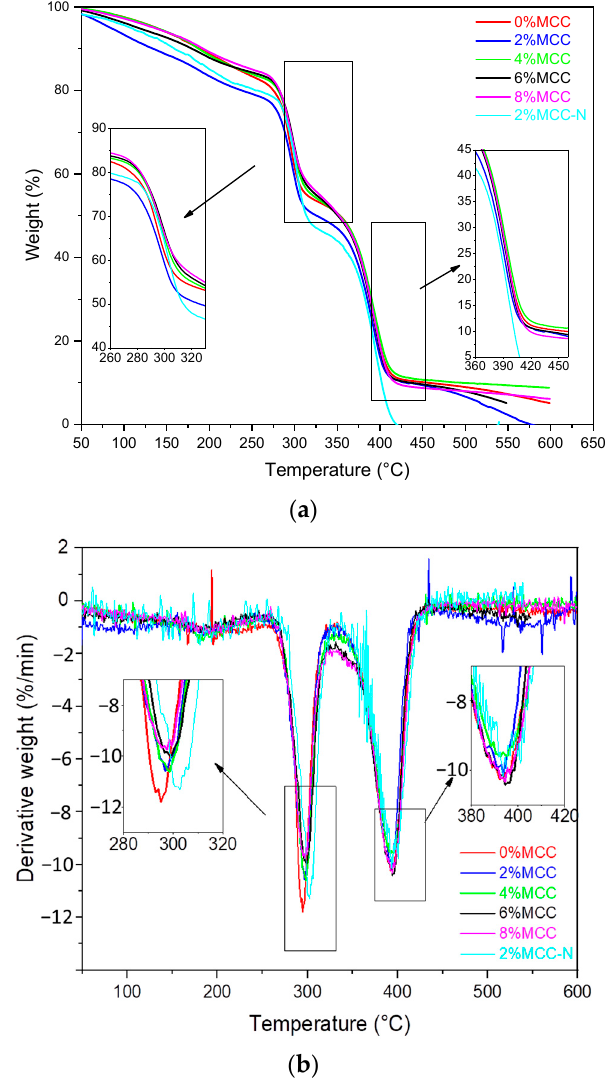
Figure 5. The curves of thermogravimetric analysis (TGA) ( a ) and DTG ( b ). Table 3. The parameters of the thermogravimetric analysis of PBAT/TPS/MCC composites. Samples